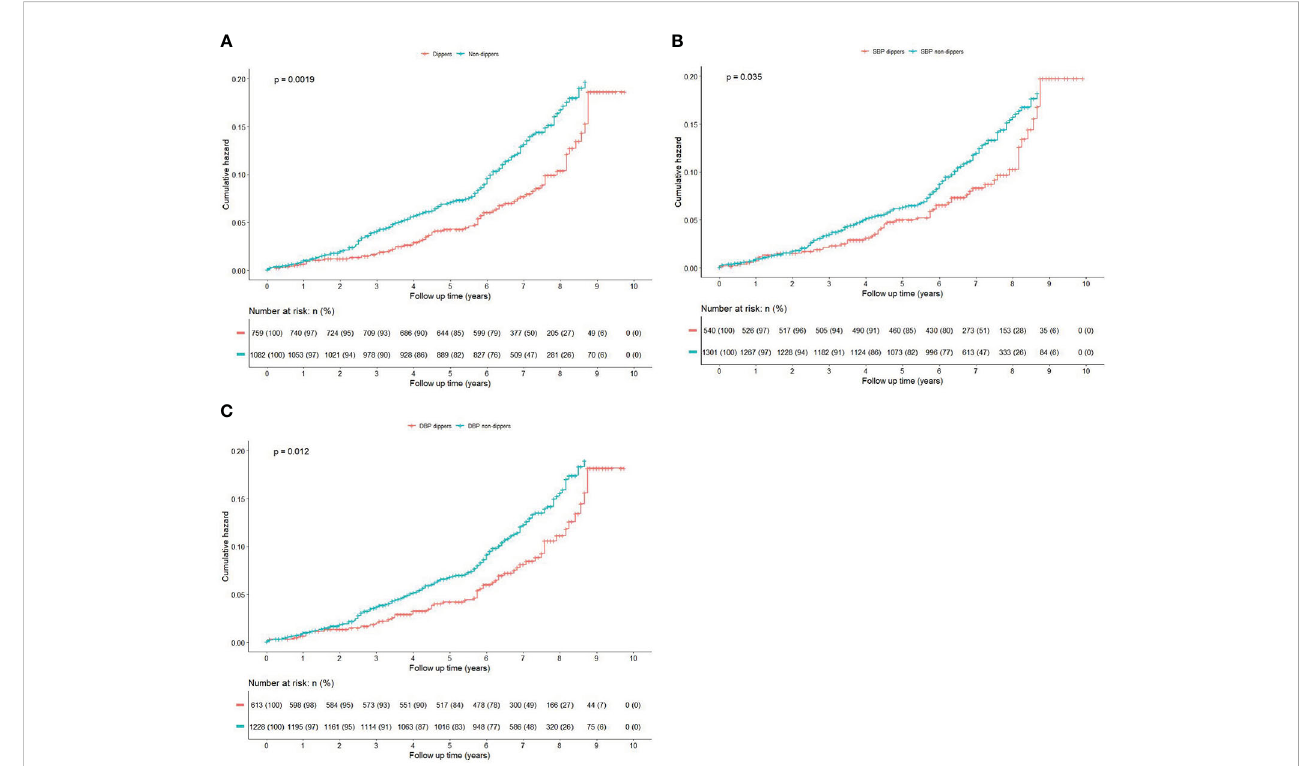
FIGURE 3 (Color online) Kaplan-Meier curves for the cumulative risk of new-onset diabetes by dipping and non-dipping pattern during the follow-up. Kaplan-Meier curves were compared with the log-rank test. (A) BP non-dippers vs dippers; (B) Systolic BP non-dippers vs dippers; (C) Diastolic BP non-dippers vs